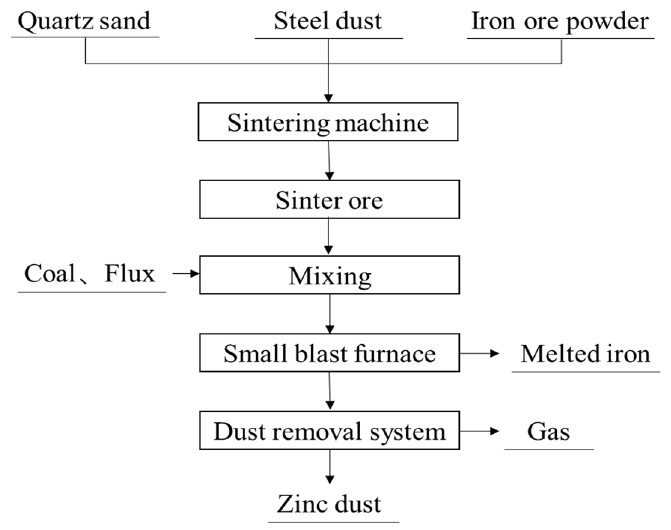
Figure 9. Flow chart of OxyCup process [33,40–42]. Figure 8. Flow chart of OxyCup process [33,40–42].